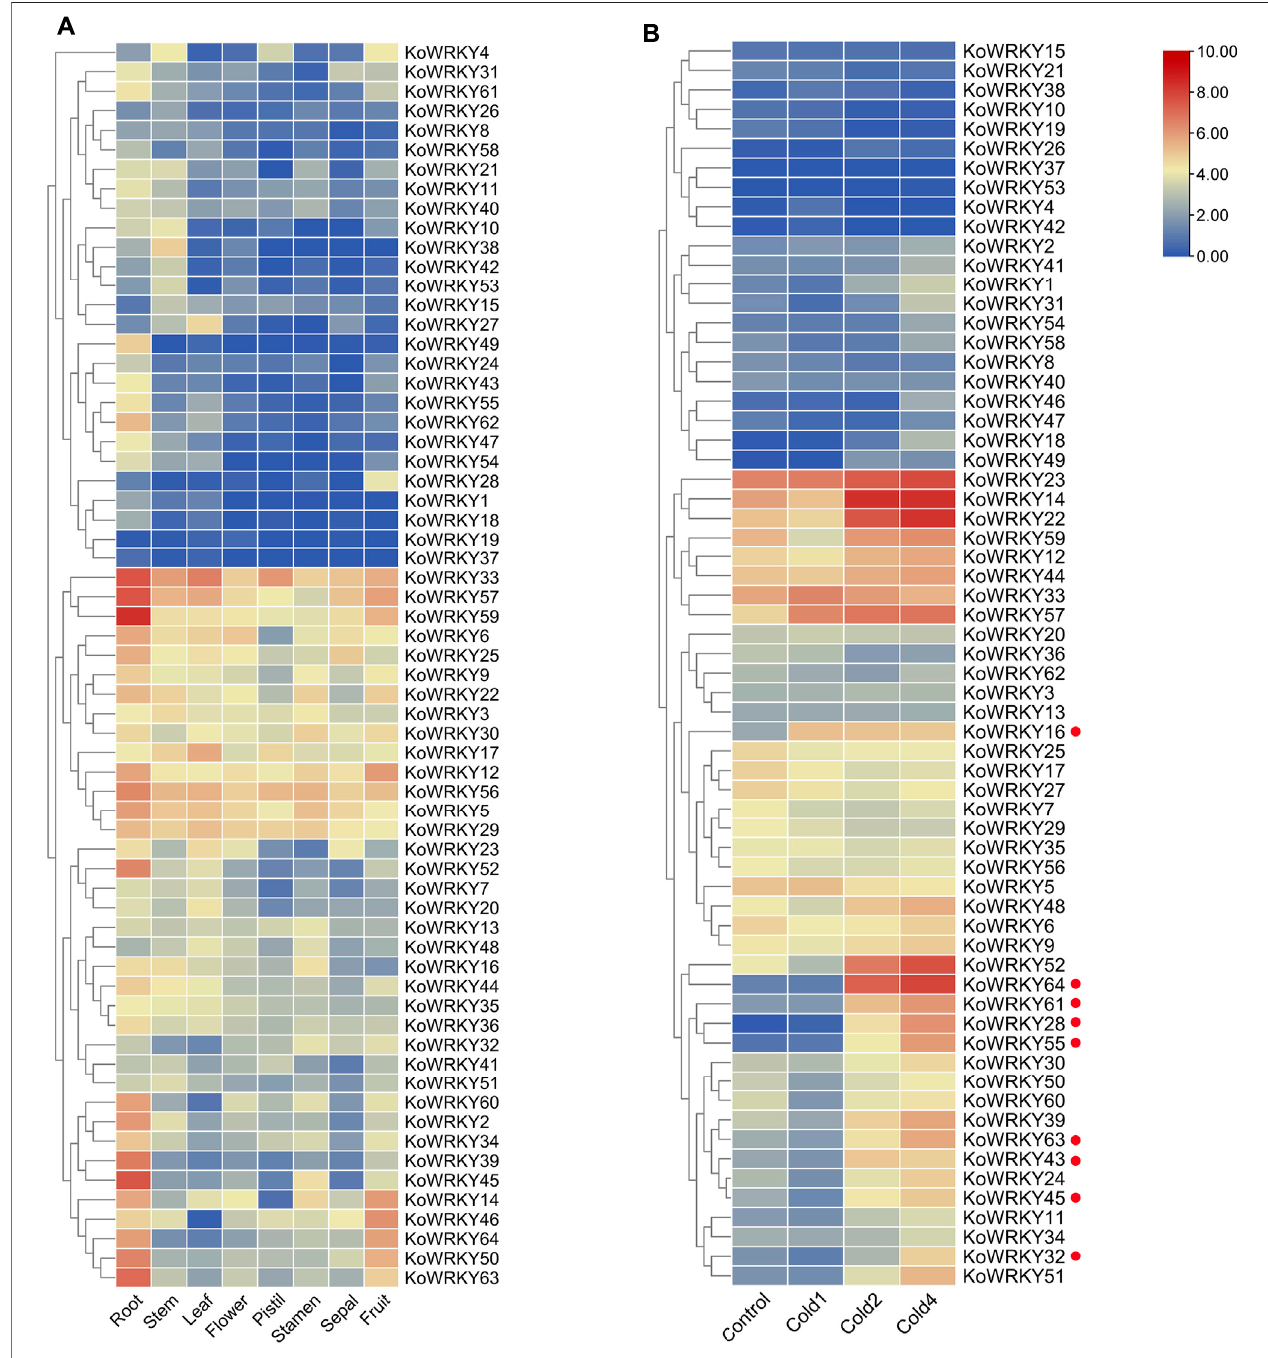
FIGURE 7 | Expression of KoWRKY genes in Kandelia obovata . (A) The transcript levels of the KoWRKY genes in 8 tissues of K. obovata were investigated based on publicly available transcriptomic data. The color scale shows increasing expression levels from blue to red. (B) The transcriptlevels of KoWRKY genes in responseto cold stress were investigated based on publicly available transcriptomic data. Cold1, fi rst cold treatment; Cold2, second cold treatment; Cold4, fourth cold treatment. The genes whose expression increased more than two-fold after cold treatment are labeled with red dots.